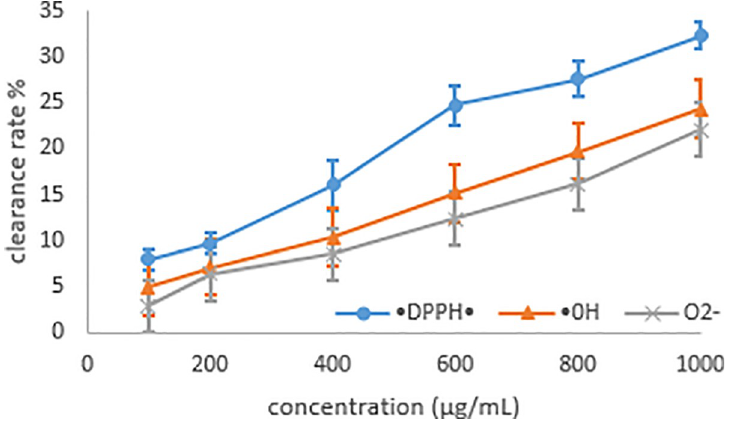
Fig 13. Scavenging capacities of MRYP for DPPH, OH, and �